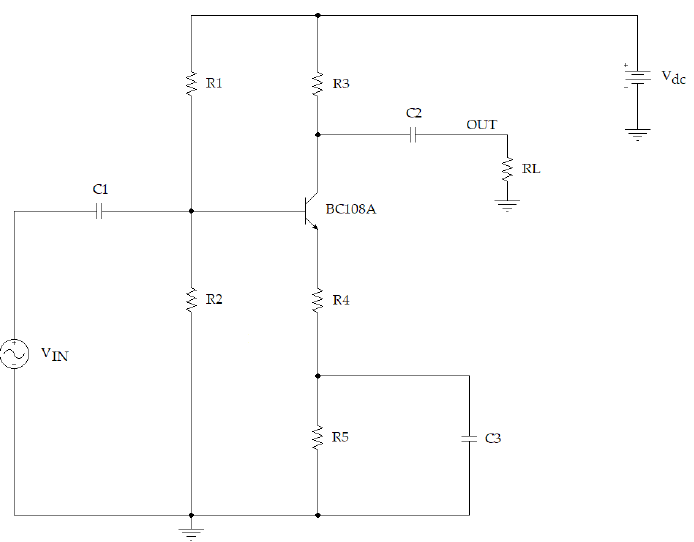
Figure 1. Electrical diagram of the single stage of a small signal BJT amplifier.